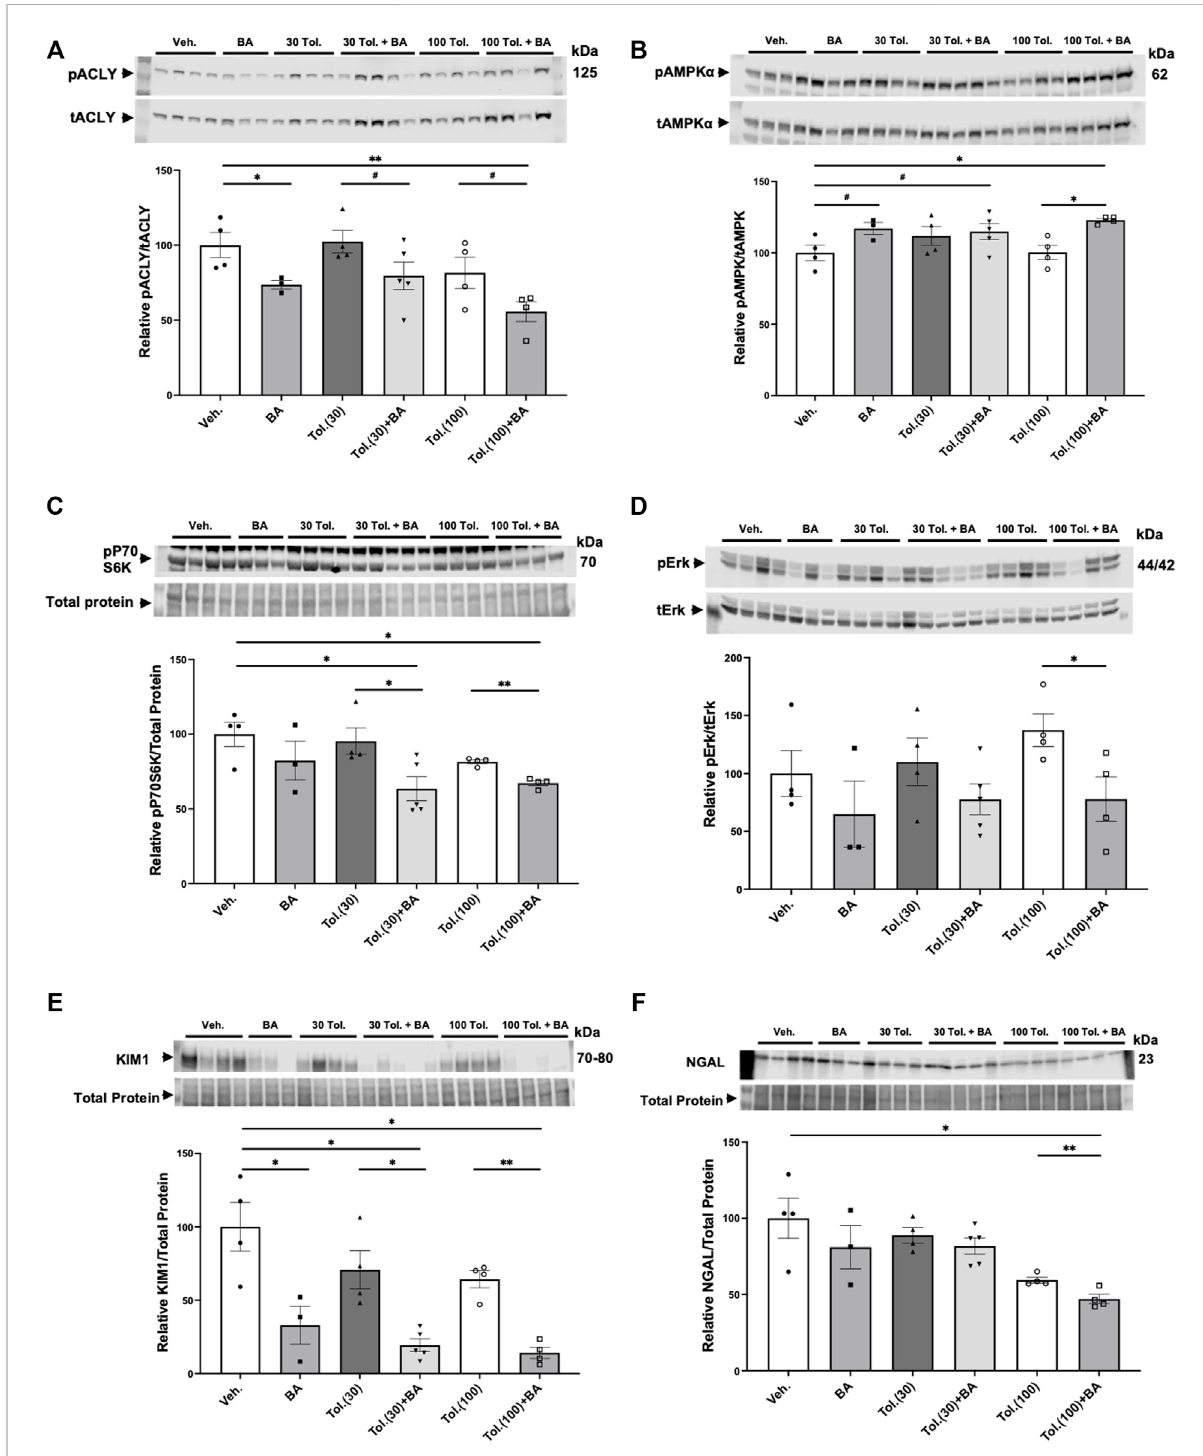
Effects ofbempedoic acid and tolvaptan treatmentinPKD mice onprotein expression ofkey signaling and injury markers in kidney homogenates. Immunoblotswereperformedonkidneytissuehomogenatesfrom Pkd1 fl / fl ;Pax8-rtTA;Tet-O-Cre micewithearly/rapidinduced Pkd1 geneinactivation withorwithoutconcurrenttreatmentwithBA(30 mg/kg/d)and/ortolvaptan(30or100 mg/kg/d).Densitometricintensitiesofimmunoblotbandsfrom eachlanewerenormalizedtothetotalproteinsignalfromthatlaneasaloadingcontrol[showninmiddlepanelsof (C) , (E) ,and (F)